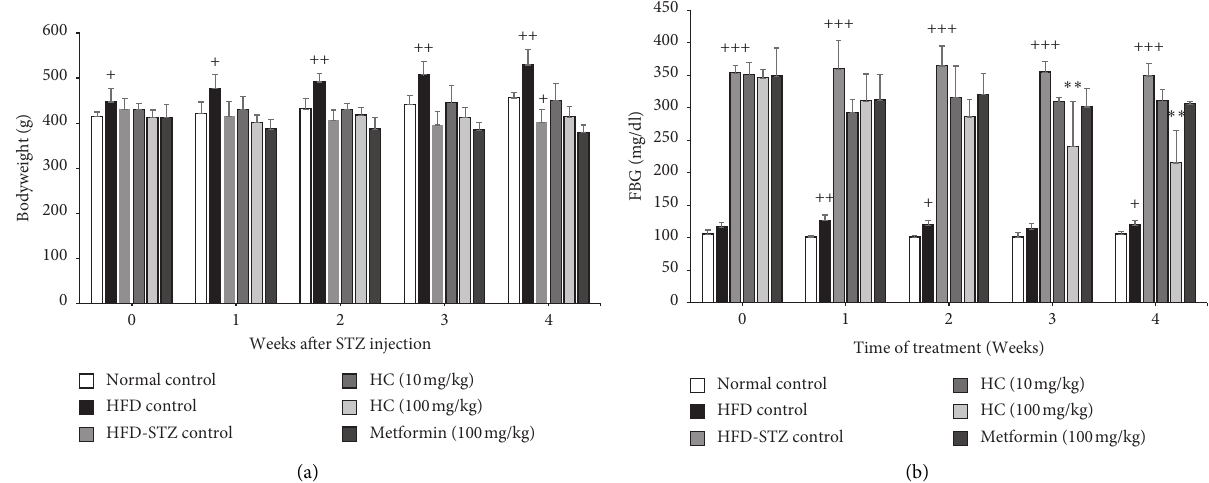
Figure 3: Effect of HC on rats’ bodyweight and fasting blood glucose. (a) Weekly bodyweight and (b) fasting blood glucose (FBG) level of each group. + p < 0 . 05, ++ p < 0 . 01, and +++ p < 0 . 001 versus normal control group. ∗∗ p < 0 . 0001 versus HFD-STZ control group. Results are presented as means ± SD ( n � 6 each